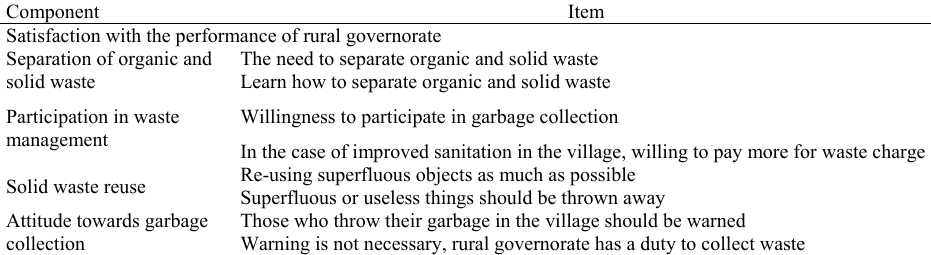
Table 4: The population's attitude towards waste management in the village Component